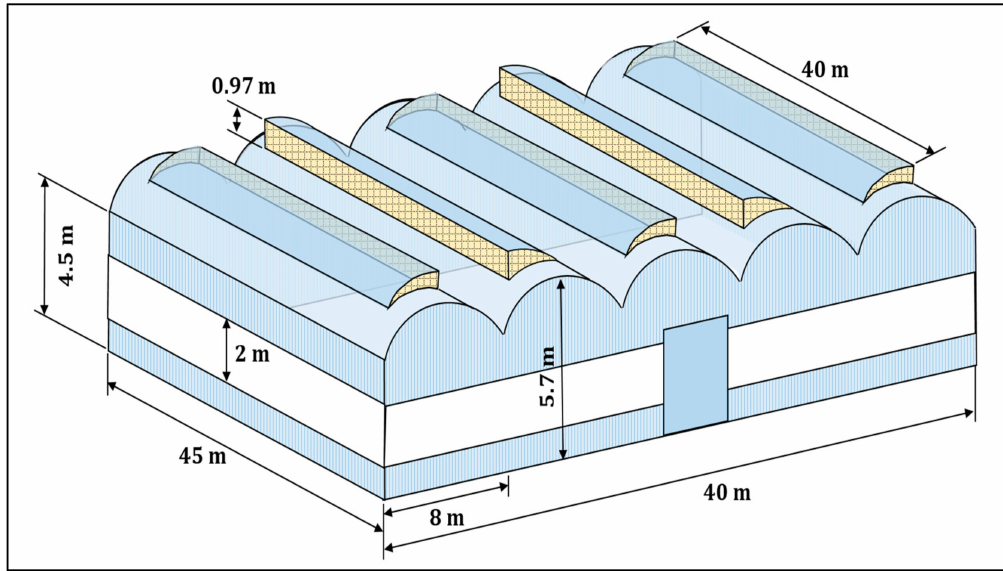
Figure 1. Outline of the experimental trial greenhouse located in the Southeast